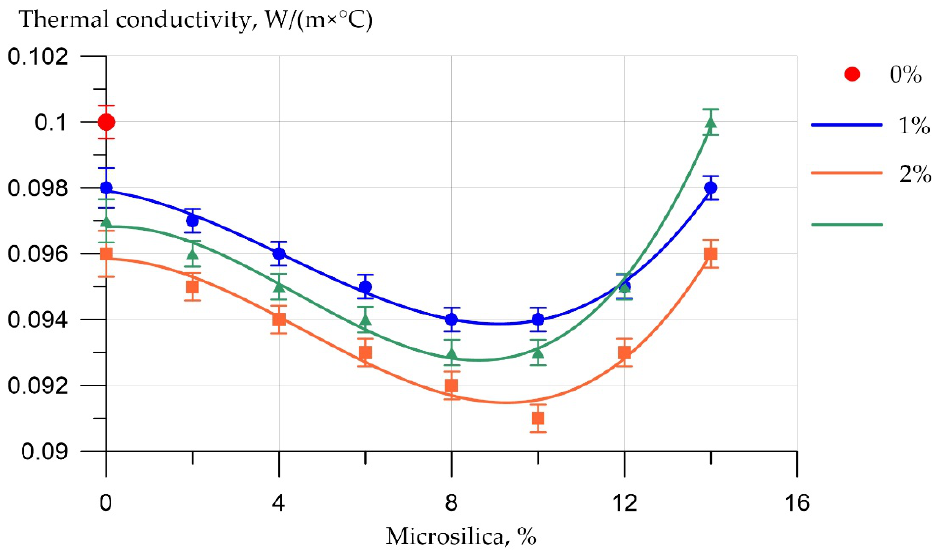
Figure 13. Results of experimental studies of the thermal conductivity of fiber foam concrete sam- ples at various dosages of microsilica introduced instead of a part of the binder and dosages of polypropylene fiber of 0%, 1%, 2%, 3%.